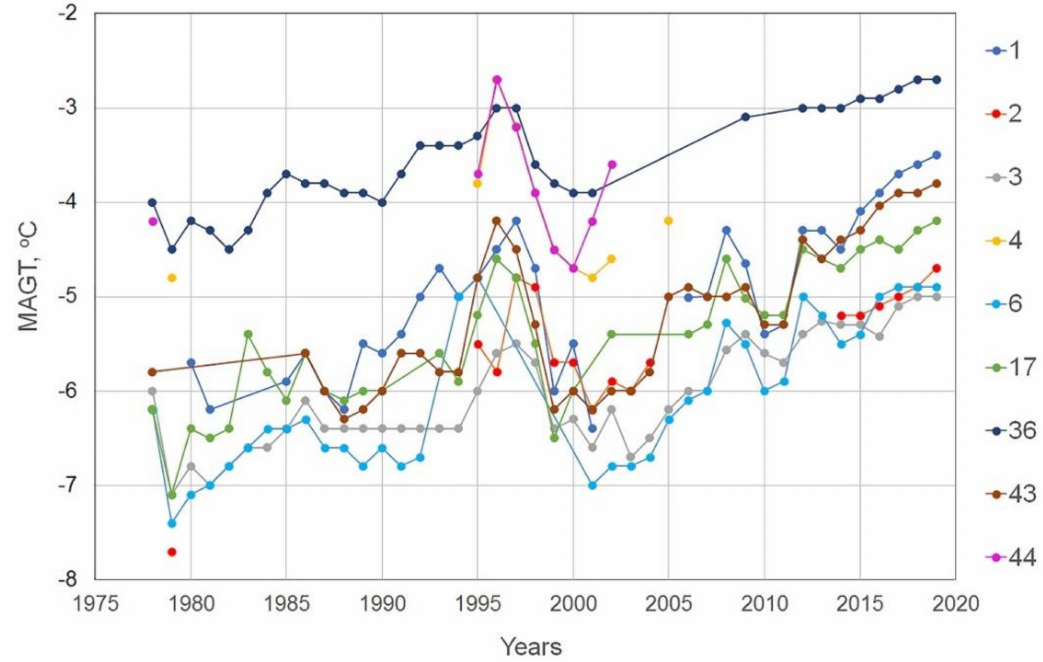
Figure 5. Mean annual ground temperature (MAGT) at maximum depth (10 or 12 m) in the